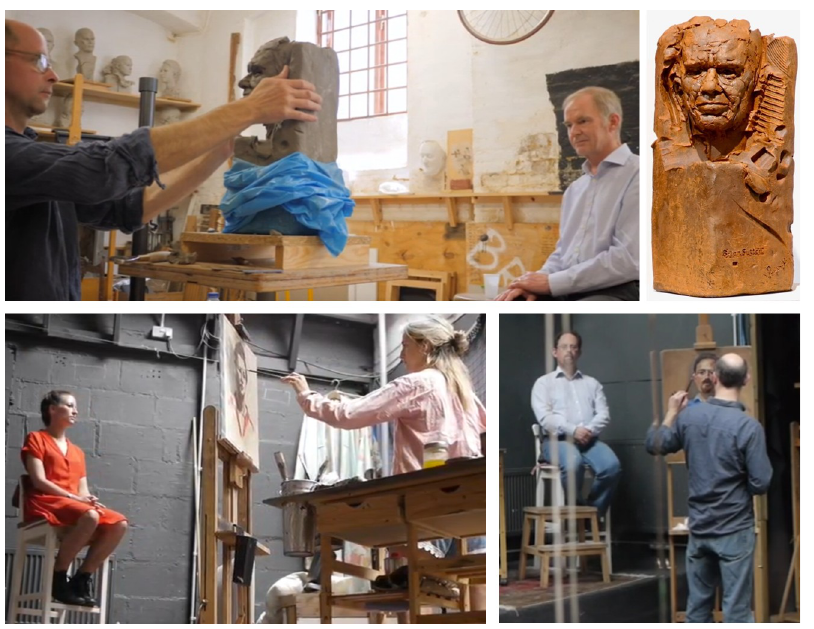
Fig 2. (Top left) “It was an extraordinary experience being looked at by you.” Brian Sutton sculpted by Scott Pohlschmidt. (Top right) Finished sculpture cast in resin. (Bottom left) Clemmie St. John Webster viewing/painting Megan Dowie. (Bottom right) Scott viewing/painting Julian